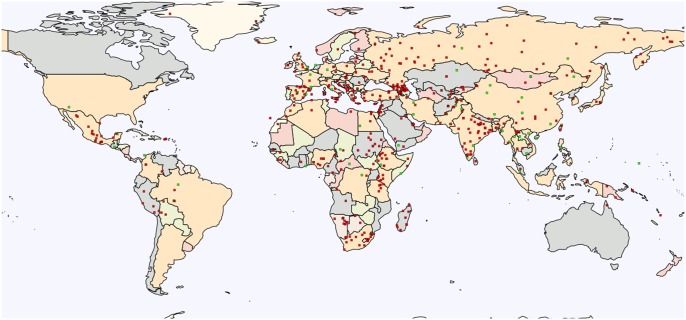
—Worldwide distribution of population from which AIMs were obtained. AIMs from over 450 world populations were harvested from the literature (green) or calculated based on genotyped data from public collections (red).